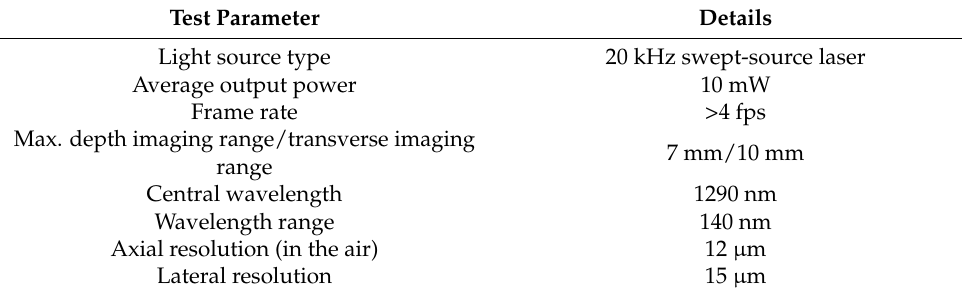
Table 3. The OCT system features